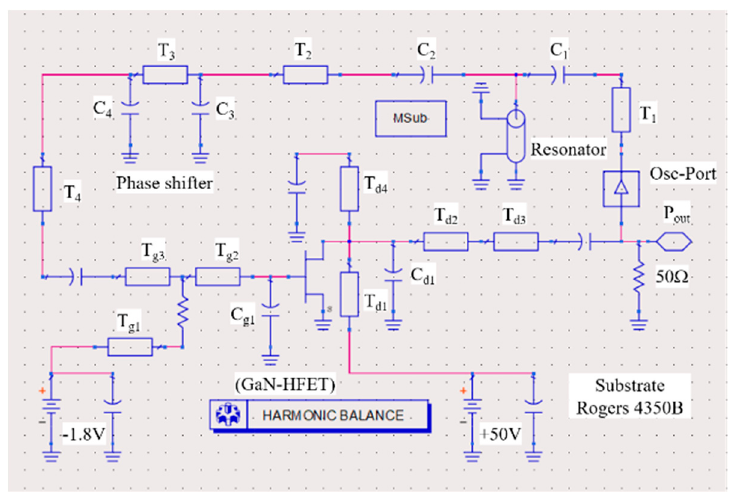
Appl. Sci. 2019 , 9 , x FOR PEER REVIEW Figure 7. Precise schematic diagram of the high power oscillator connecting Ports 1 and 3.